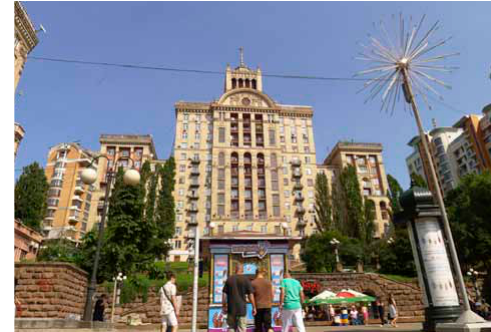
fig. 6. The central entrance to the recreation park. fig. 8. The architecture of the Kyiv Kreshchiatik.